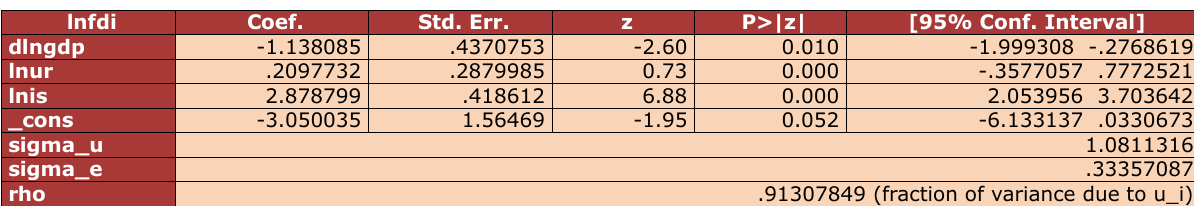
Table 7. The result of Fixed effect model of panel data of Guangdong